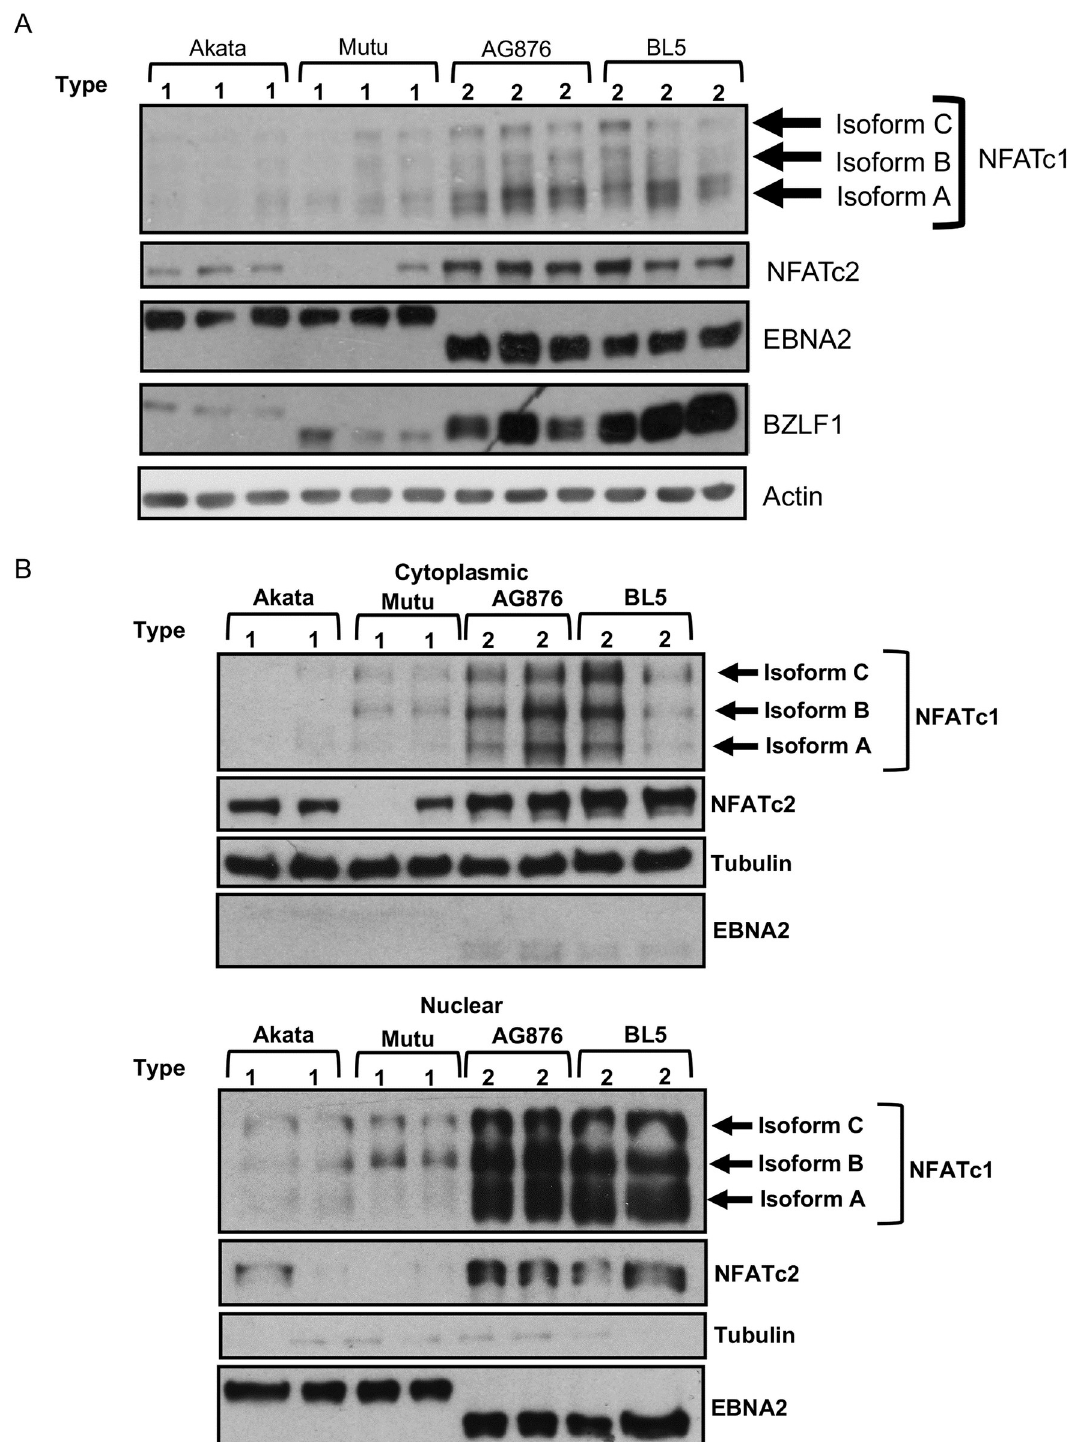
Fig 9. T2 EBV-infected LCLs have elevated total and activated (nuclear) NFATc1 and NFATc2 compared to T1 EBV-infected LCLs. A) Whole cell extracts from T1 and T2 EBV-infected LCLs were subjected to immunoblot analysis using antibodies against NFATc1, NFATc2, EBNA2, Z, and actin. B) Cellular fractionation was performed on T1 and T2 LCLs and fractionation samples were subjected to immunoblot analysis. Upper) Immunoblot analysis performed on cytoplasmic fraction using antibodies against NFATc1, NFATc2, EBNA2 (nuclear fraction control), and Tubulin (cytoplasmic fraction control). Lower) Immunoblot analysis performed on nuclear fraction using antibodies against NFATc1, NFATc2, EBNA2 (nuclear fraction control), and Tubulin (cytoplasmic fraction control).